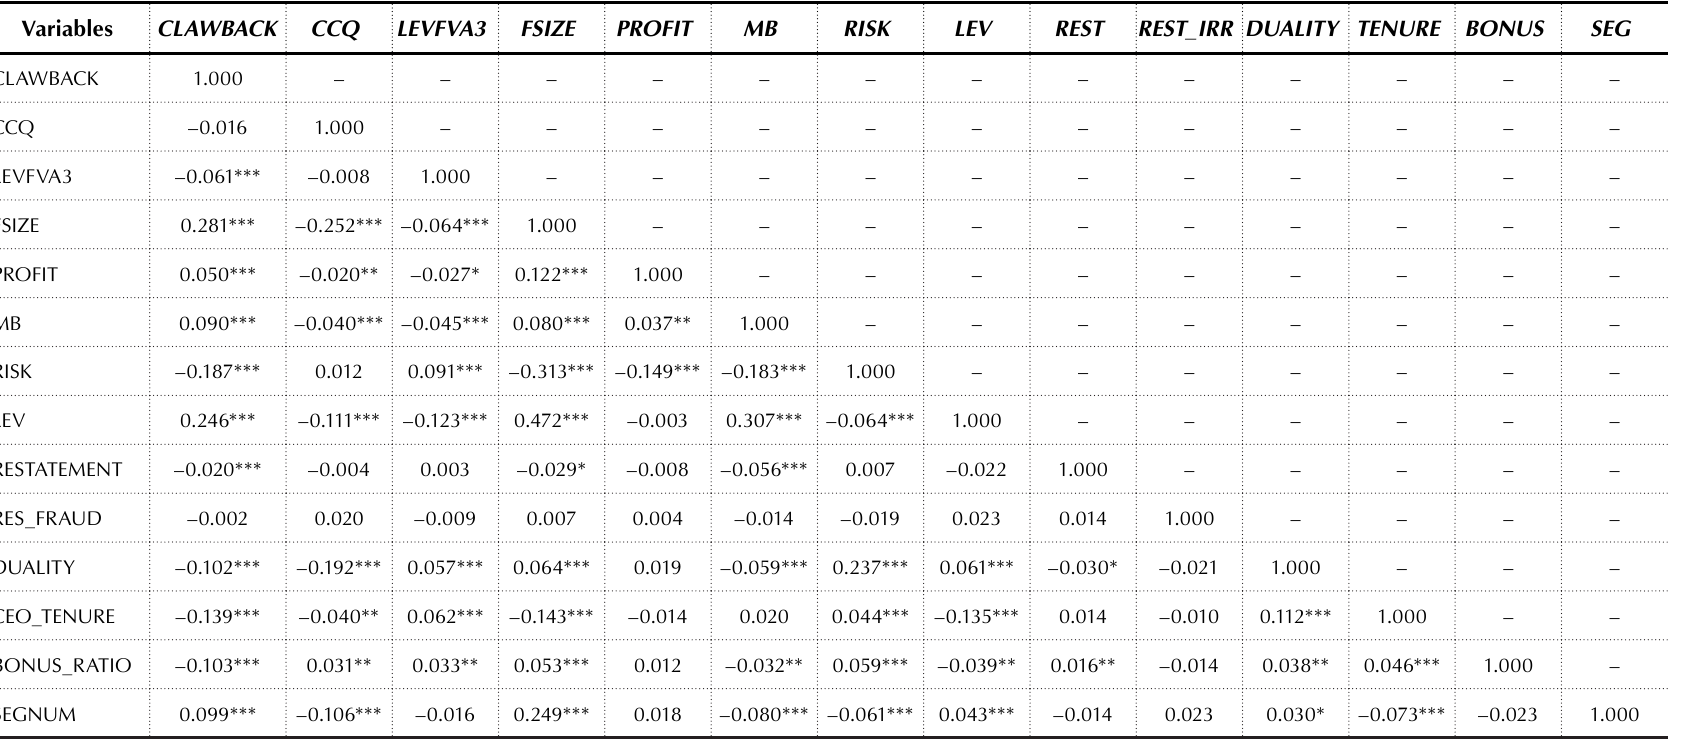
Table 2. Correlation